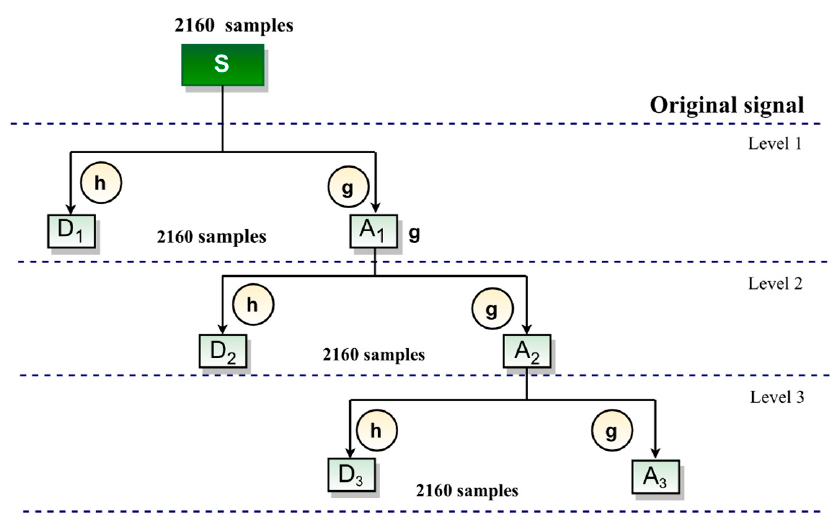
Figure 3. Illustrative example of MODWT filtering process [28]. The MODWT scale filter (cid:101) h j , (cid:96) and the wavelet filters (cid:101) g j , (cid:96) are defined in (1) and (2) based on the DWT filters g j , (cid:96) (low-pass) and h j , (cid:96) (high-pass) [24–27]: